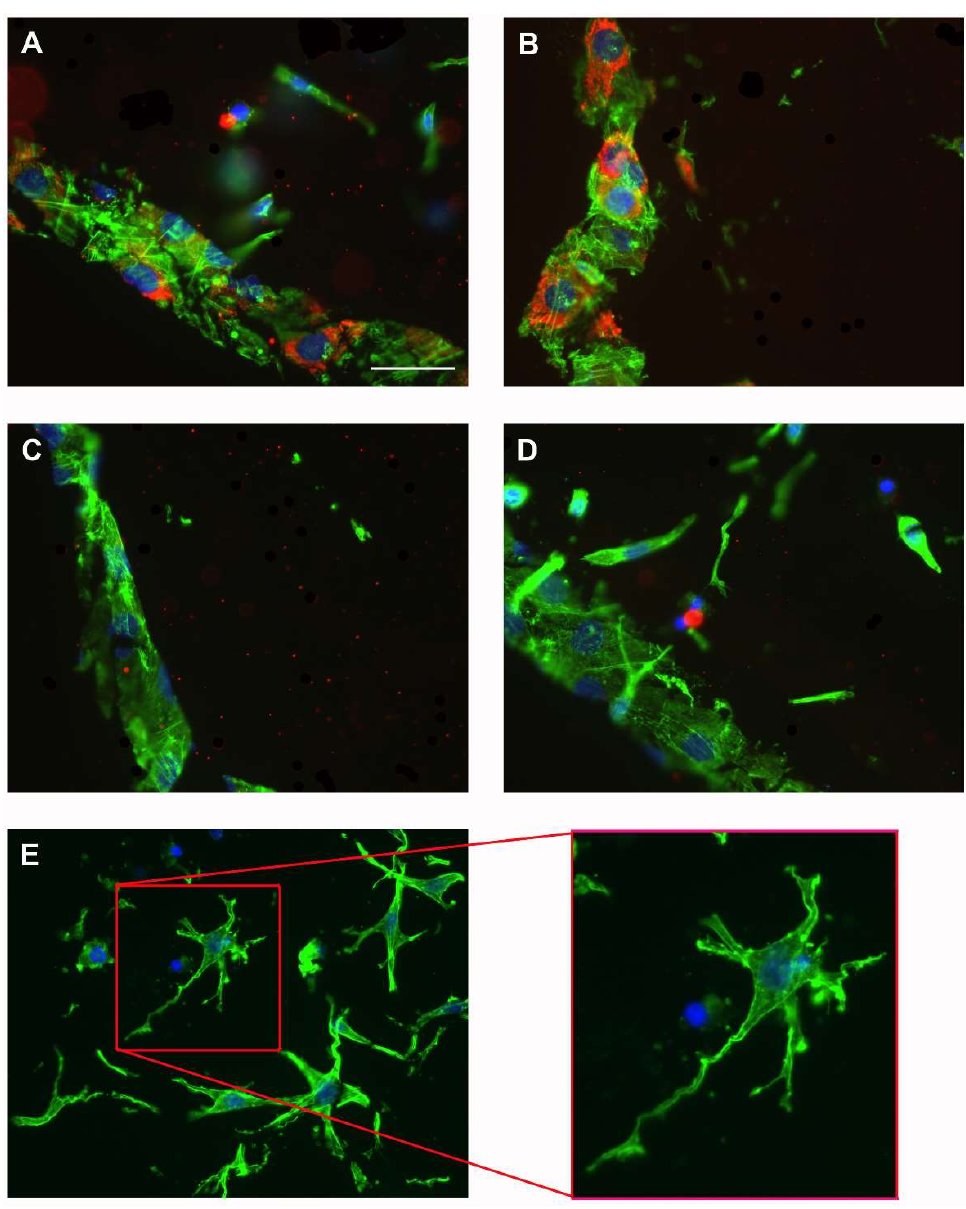
Figure 4. Fluorescent micrographs represent immuno-labelling of β-actin (Alexa 488, green) and the C-terminal propeptide of type I collagen (Alexa 594, red) in combination with DAPI nuclear staining (blue) ( n = 4 replicates/experiment, 3 experiments). Shown are the micrographs for labelled surface MG-63 osteoblast-like cells on culture day 4 ( A – D ). ( A ) αMEM + FCS, ( B ) αMEM SF, ( C ) αMEM + FCS + TGFβ 3 , and ( D ) αMEM SF + TGFβ 3 . ProCI labelling in TGFβ 3 -containing medium was not yet present on day 4. MLO-Y4 osteocyte-like cells in co-culture demonstrated dendritic phenotype, these embedded cells inside the gel were negative for ProCI staining ( E ). Insert was magnified 2×. Scale bar represents 20 μm.